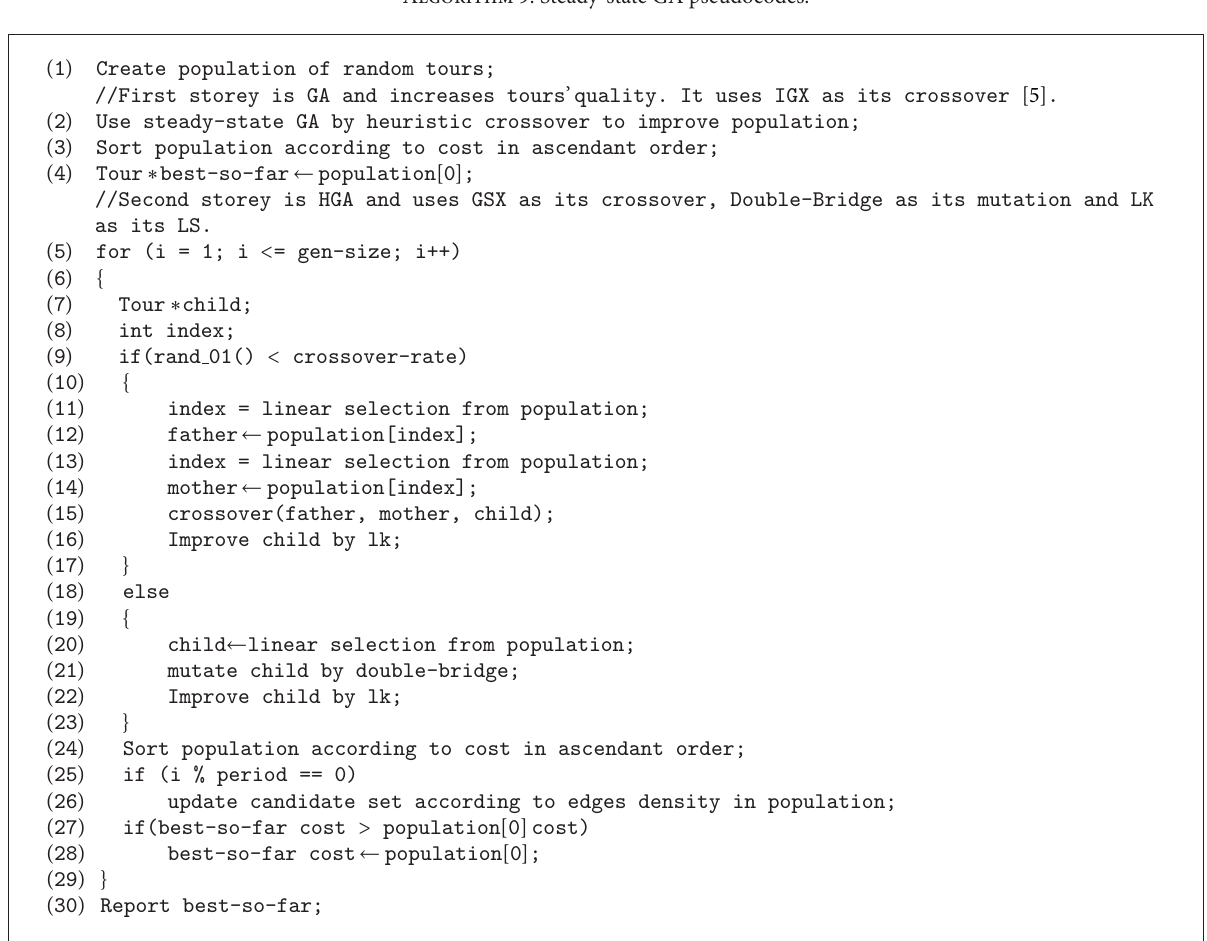
Algorithm 10: Our HGA’s